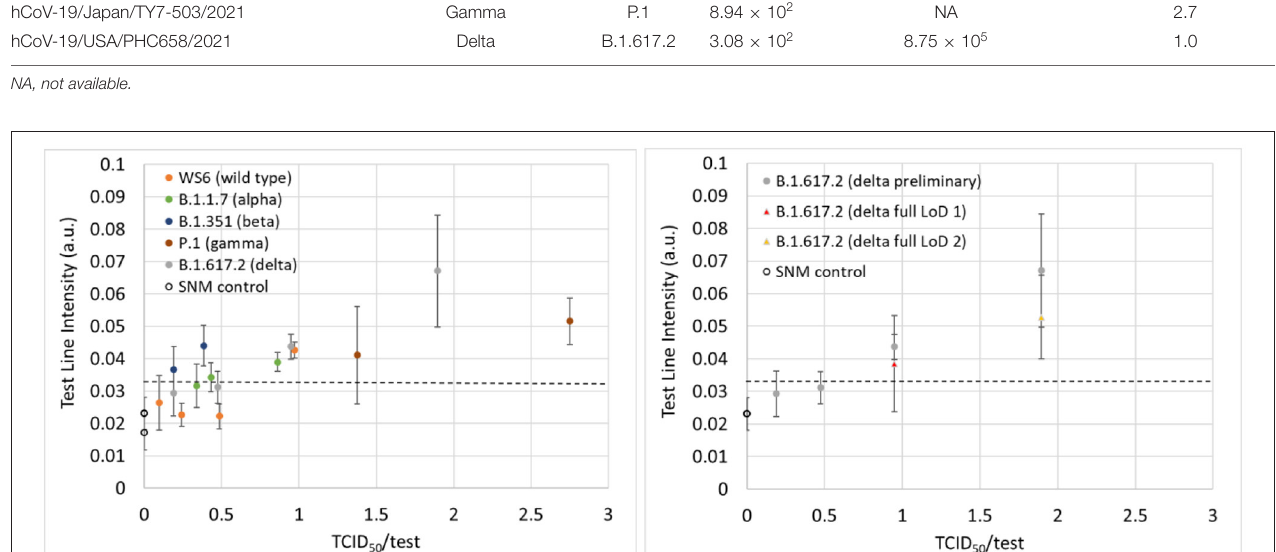
FIGURE 2 | (Left) Test line intensities plotted as a function of the TCID 50 /test for the wild type and four variants from the preliminary LoD studies. (Right) The test line intensities for the delta variant for both the preliminary (gray data points) and confirmatory (yellow and red data points) LoD experiments. The dashed line represents the positive/negative